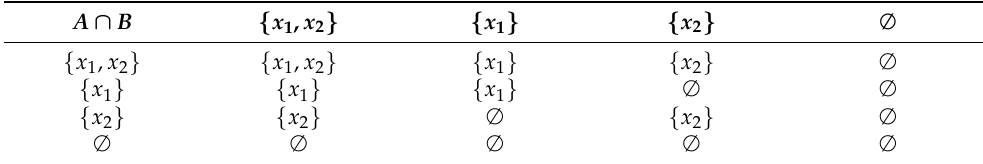
Table 3. Intersection in set